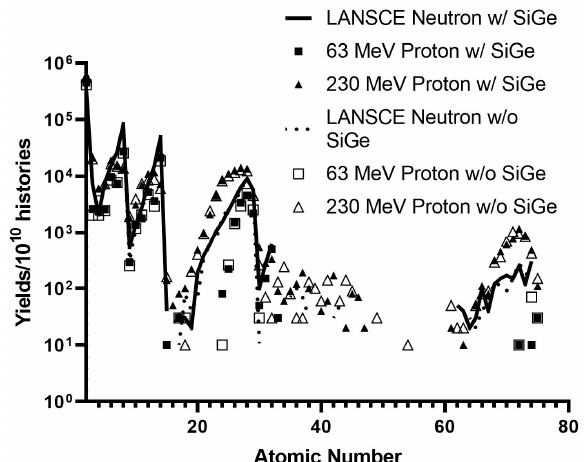
Figure 8. The secondary particle yields in the structure with and without SiGe irradiated by 63 and 230 MeV protons and LANSCE neutron.